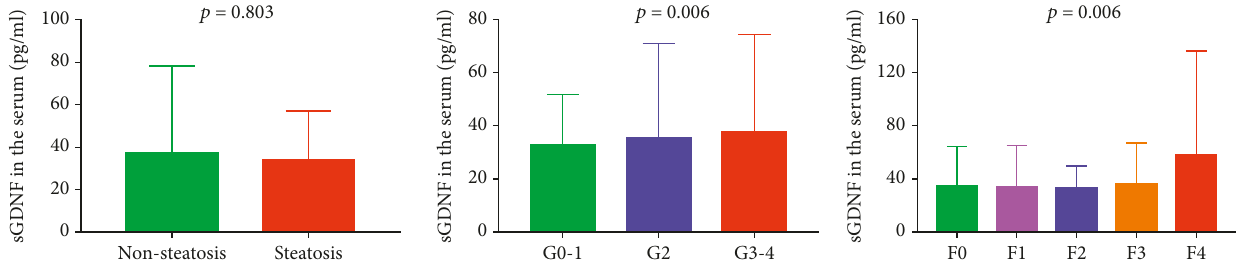
Figure 2: sGDNF levels according to the histological grade and fibrosis stage in 344 patients. Liver histopathology of patients with G0, G1, G2, G3, and G4 according to the Scheuer scoring system. G1, portal inflammation; G2, mild piecemeal necrosis; G3, moderate piecemeal necrosis; G4, severe piecemeal necrosis and bridging necrosis. METAVIR scoring system. F0, no fibrosis; F1, portal fibrosis without septa; F2, septal fibrosis (portal-portal); F3, septal fibrosis (portal-central); F4,